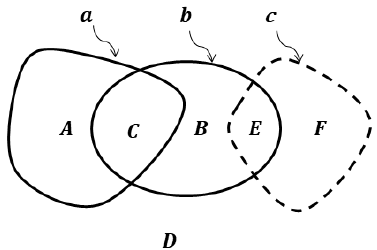
Figure 2. Euler-Venn diagram for ER between figures 𝑎 , 𝑏, and 𝑐 .